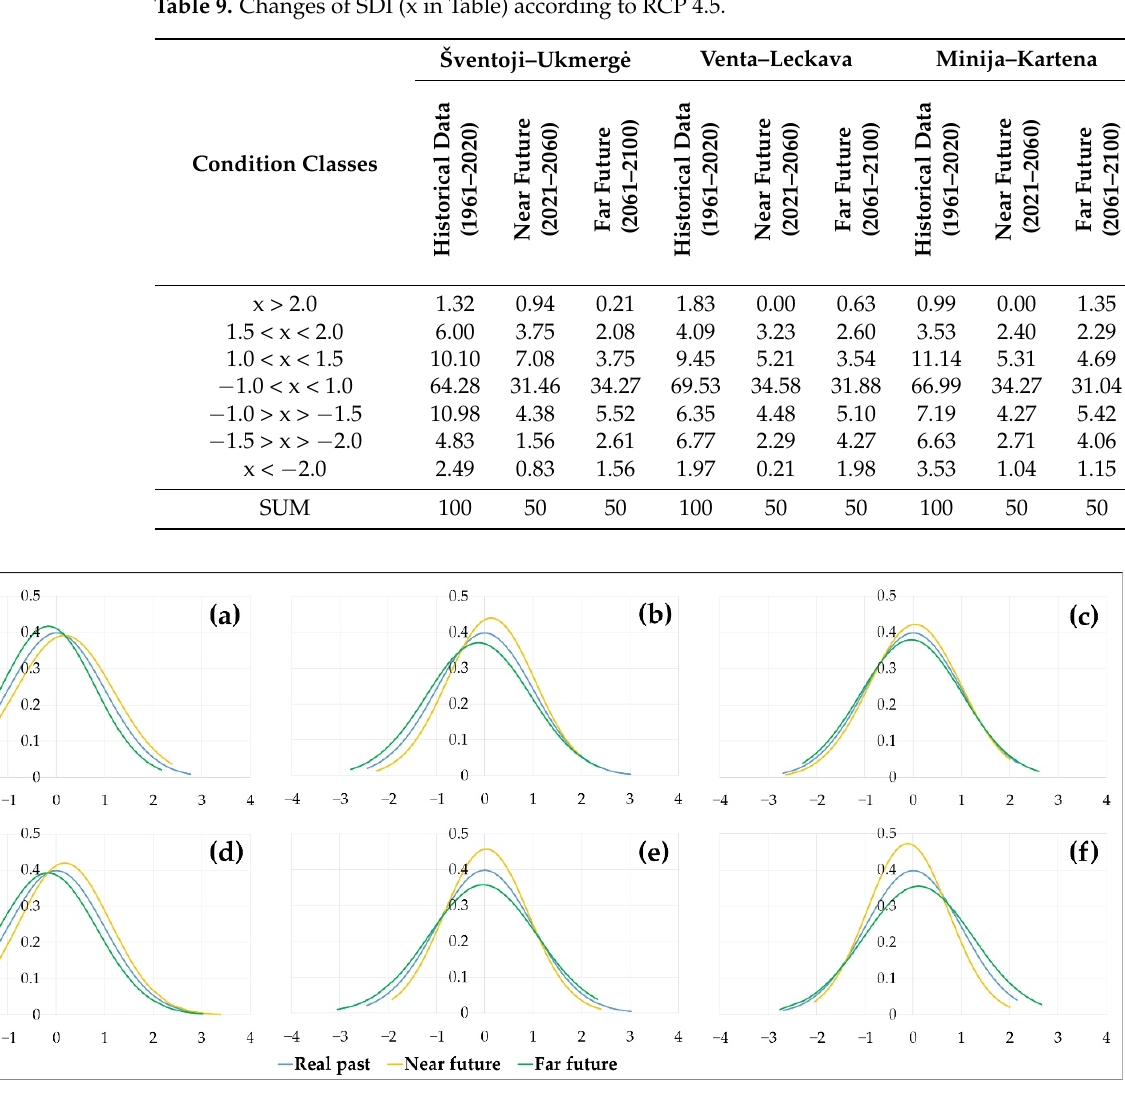
Figure 12. Deviation of SDI index with 12-month accumulation period: ( a ) Šventoji—Ukmerg˙e under RCP 4.5; ( b ) Venta—Leckava under RCP 4.5; ( c ) Minija—Kartena under RCP 4.5; ( d ) Šventoji— Ukmerg˙e under RCP 8.5; ( e ) Venta—Leckava under RCP 8.5; ( f ) Minija—Kartena under RCP